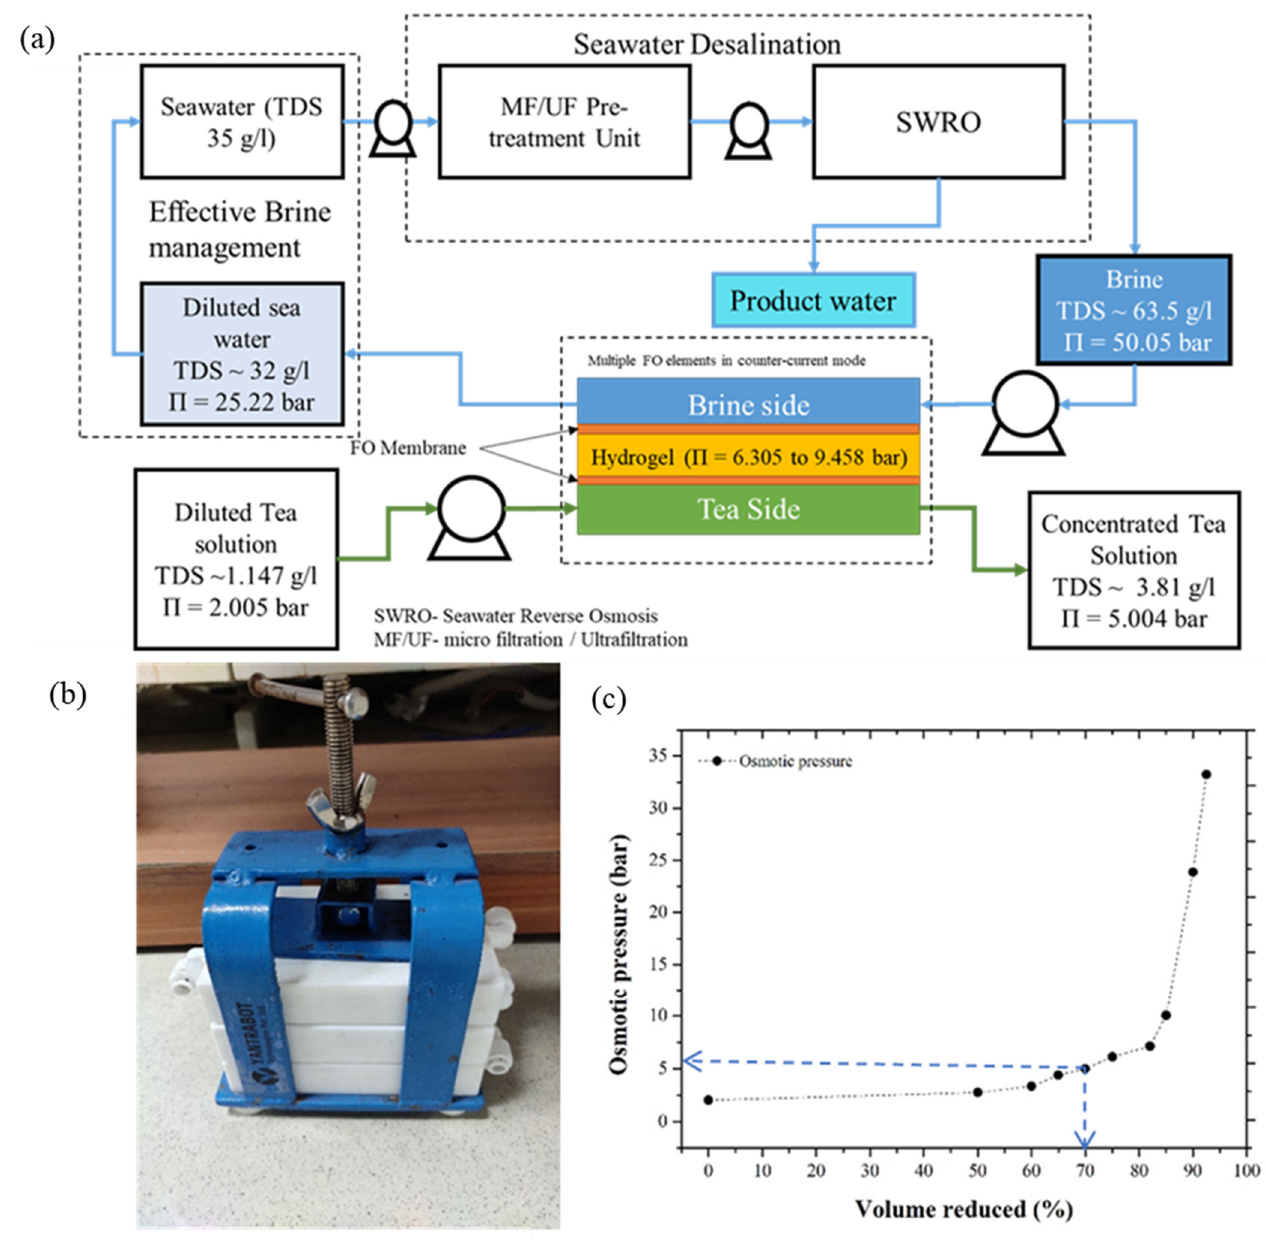
Figure 8. ( a ) Schematic representation of an integrated experimental setup for preparation of con- centrated liquid food using hydrogel as DS and RO brine; ( b ) data for correlating change in osmotic pressure with % volume reduced (for tea extract); and ( c ) setup for integrated membrane three-layer FO module for preparation of concentrated liquid